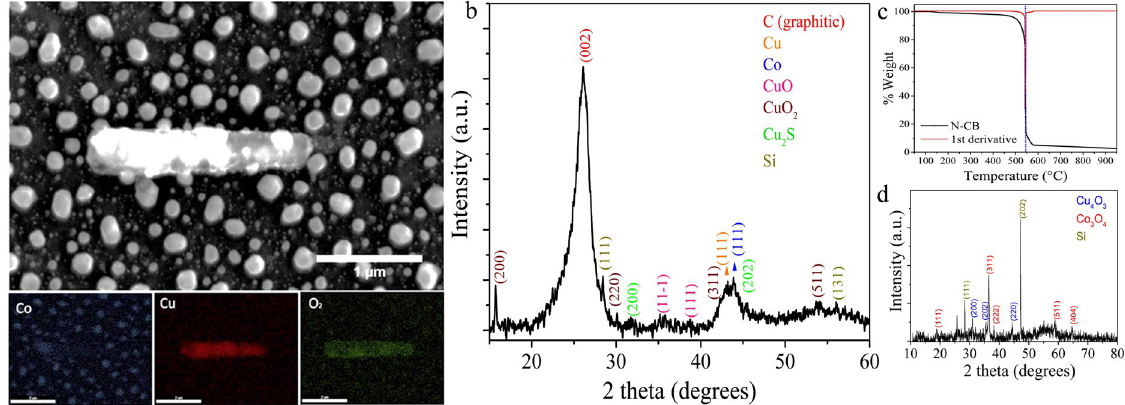
Figure 4. ( a ) SEM image of Co/Cu film exposed to heat-treatment during 2 hours in the absence of precursors. The formation of bar-shaped particles and semi-spherical are observed; the EDS-mapping analysis of cobalt (blue), copper (red) and oxygen (green) are also showed. ( b ) XRD pattern of N-CBs showing the presence graphite material including Co (FCC), Cu (FCC), CuO, CuO 2 , Cu 2 S, and Si. ( c ) TGA with an oxidation temperature of 546 °C and the remaining weight of 2.5% at 950 °C. ( d ) XRD patterns of the TGA remaining material revealing the presence of Co 3 O 4 , Cu 2 O, and